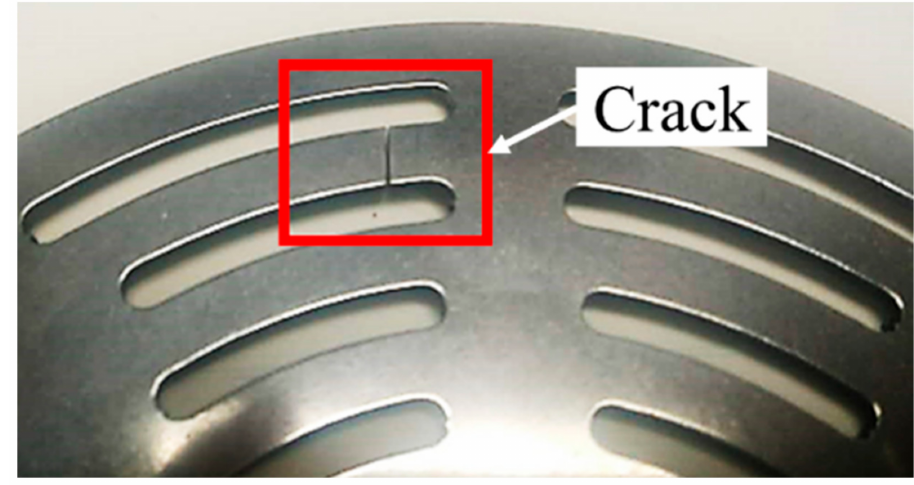
Figure 19. Cracked valve plate.